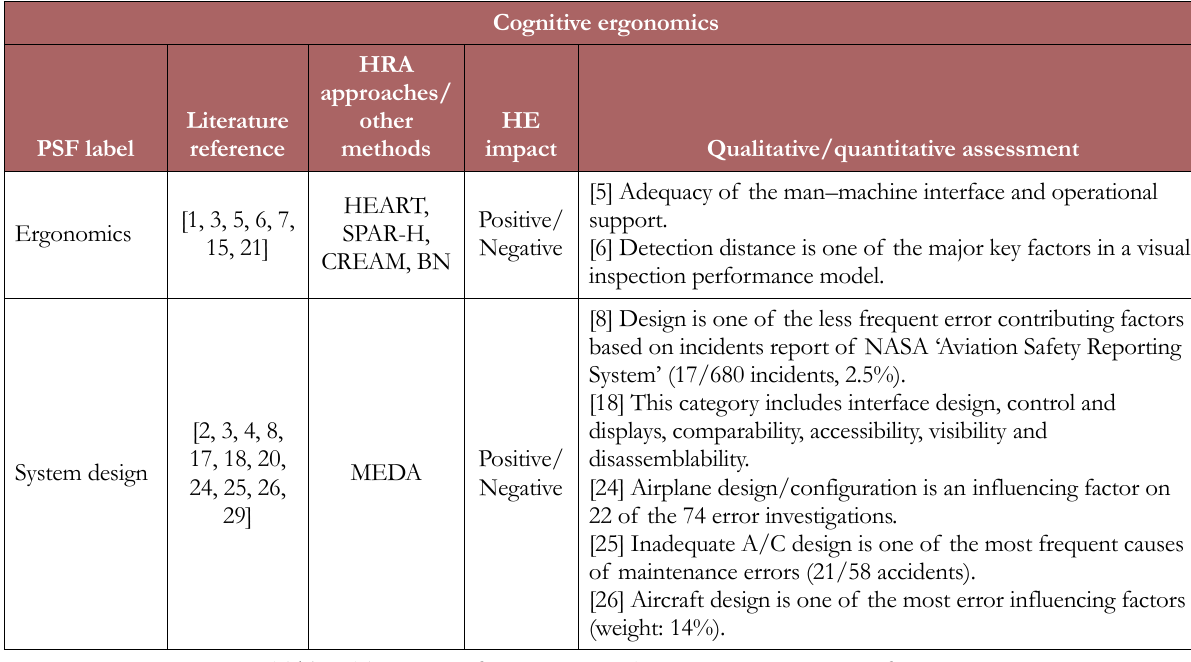
Table 8. Taxonomy of maintenance PSFs: cognitive ergonomics factor ‘Safety equipment and support tools’ (Table 9) has emerged as a PSF to be taken into account for HRA in such contexts. In fact, the tools and materials used in maintenance must be available, reliable and suitable and can vary from common to very complex tools that require more attention.